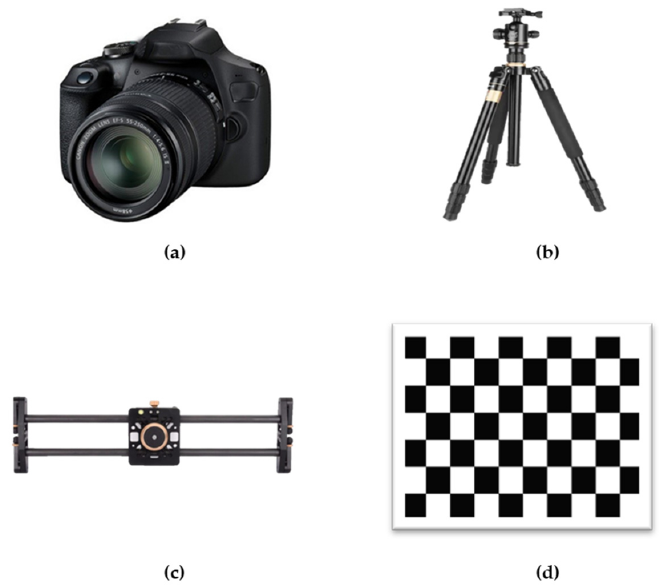
Figure 1. Experimental materials: ( a ) Canon 1500D digital camera; ( b ) camera tripod; ( c ) slide rail; ( d ) chessboard.